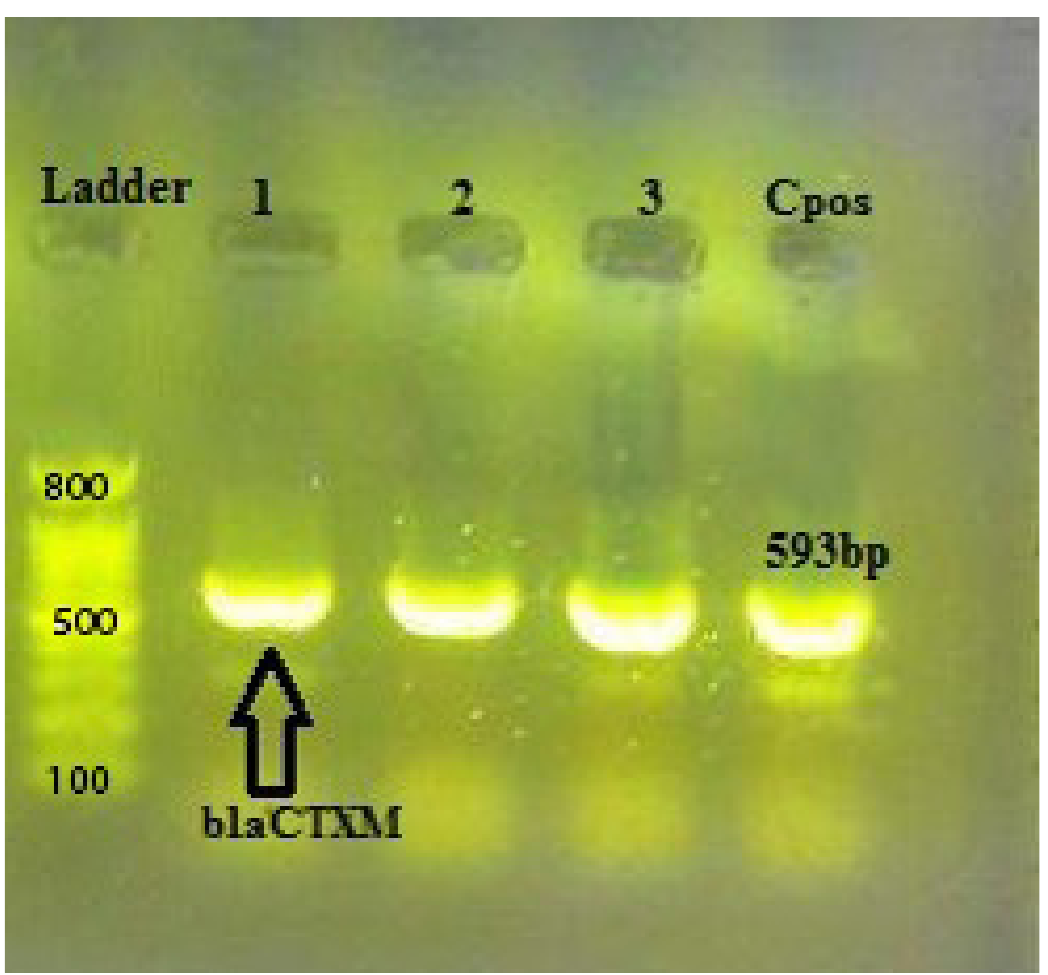
Figure 3. The result of PCR for bla C-pos: Positive control, Left line: 100bp DNA ladder, Line 1, 2 and 3: Positive isolates CTX-M